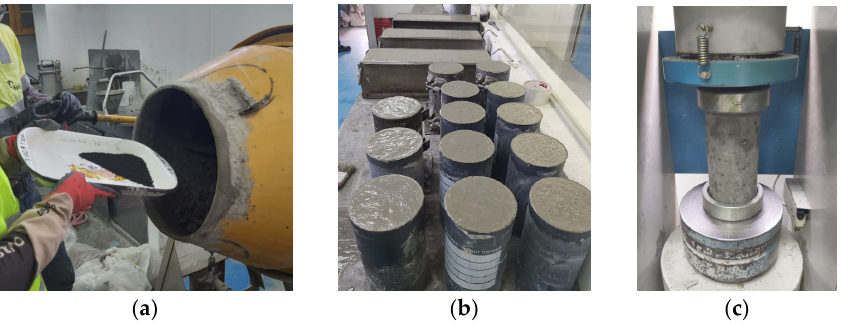
Figure 3. ( a ) rubber added in concrete mix design; ( b ) Concrete samples; ( c ) Compressive strength test.